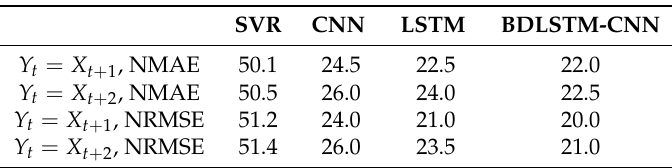
Table 1. Comparison for Error Rates